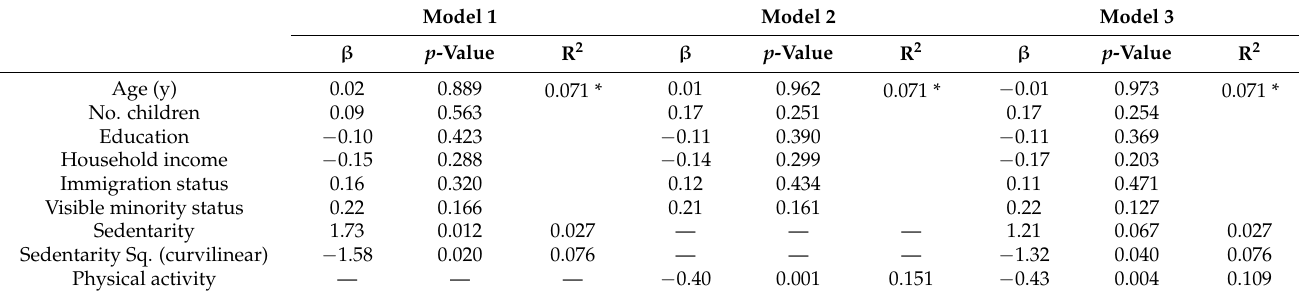
Figure 2. Relationships between sedentary behavior ( a ) and physical activity ( b ) at 16–18 weeks gestation with birthweight-for-gestational age Z-scores (BW-for-GA). Table 3. Results of multiple regression models testing relationships between sedentary behavior and physical activity at 16–18 weeks gestation with birthweight-for-gestational age Z-scores. β indicates standardized